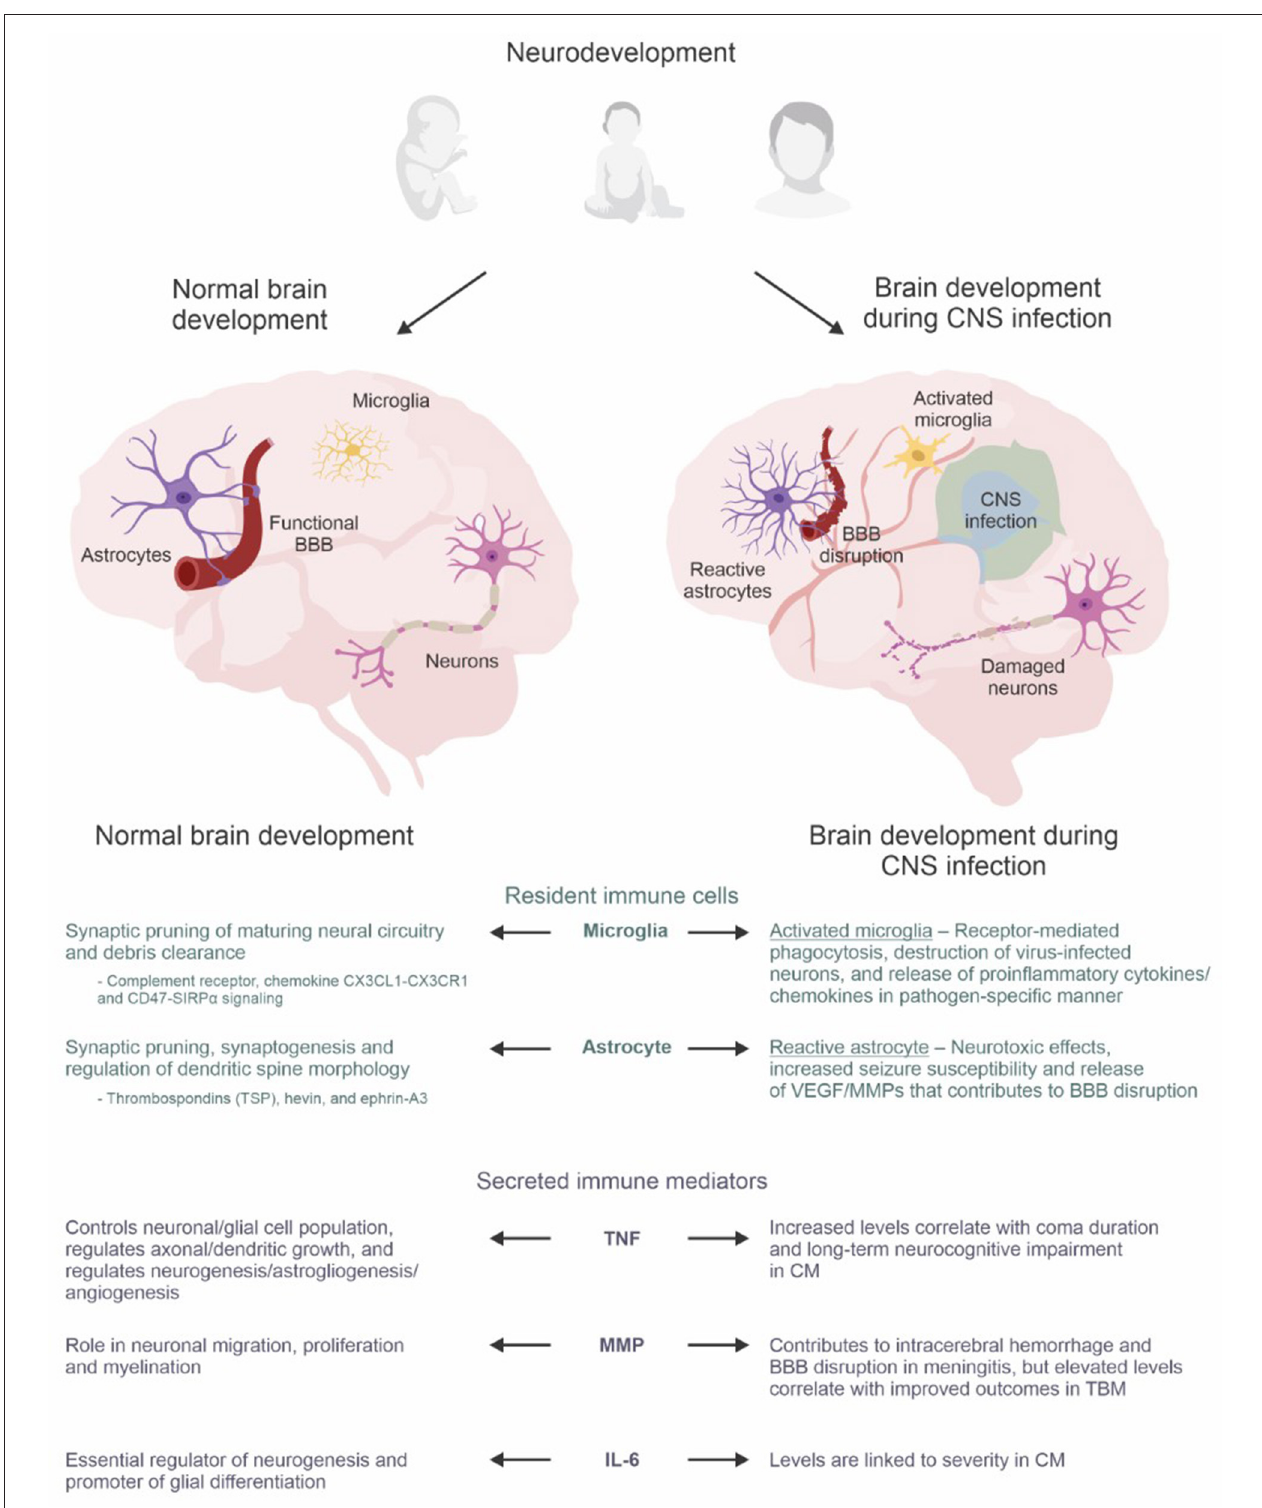
FIGURE 1 | The neuro-immune axis in the developing brain. Astrocytes, microglia, and secreted immune mediators have dual roles during normal brain development and the immune response triggered by CNS infections. During normal brain development, they are integral to synaptic pruning, regulation of